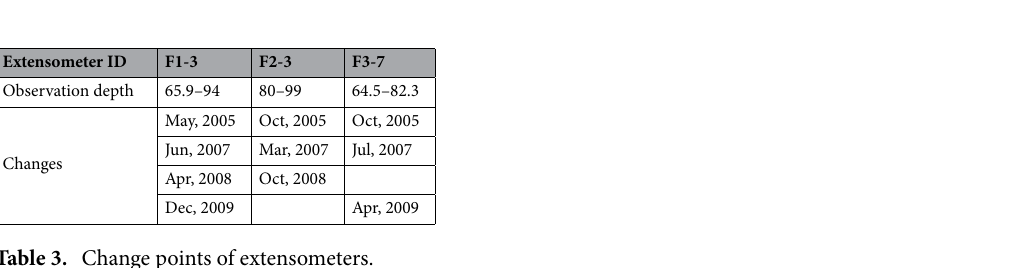
Table 3. Change points of